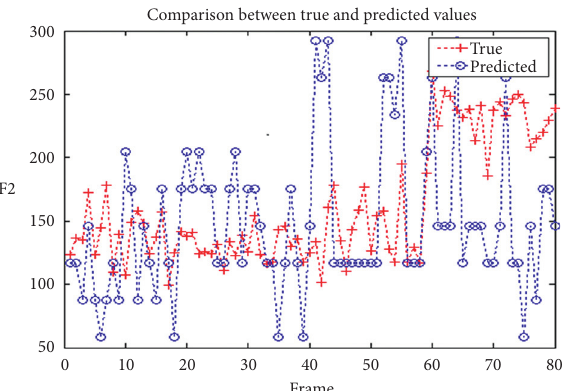
Figure 6: Comparison between true and conversed values of GMM-based